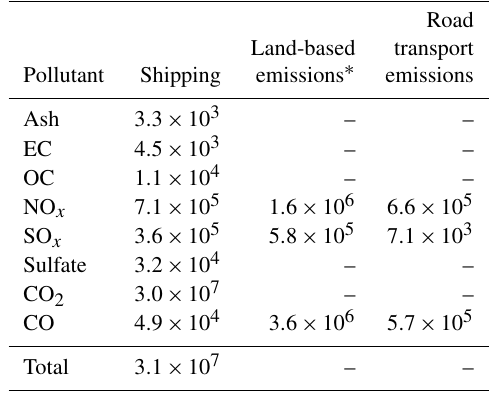
Table 2. Annual mean amounts of emitted air pollutants from shipping and from land-based anthropogenic sources during 2015 (tyr − 1 ) .